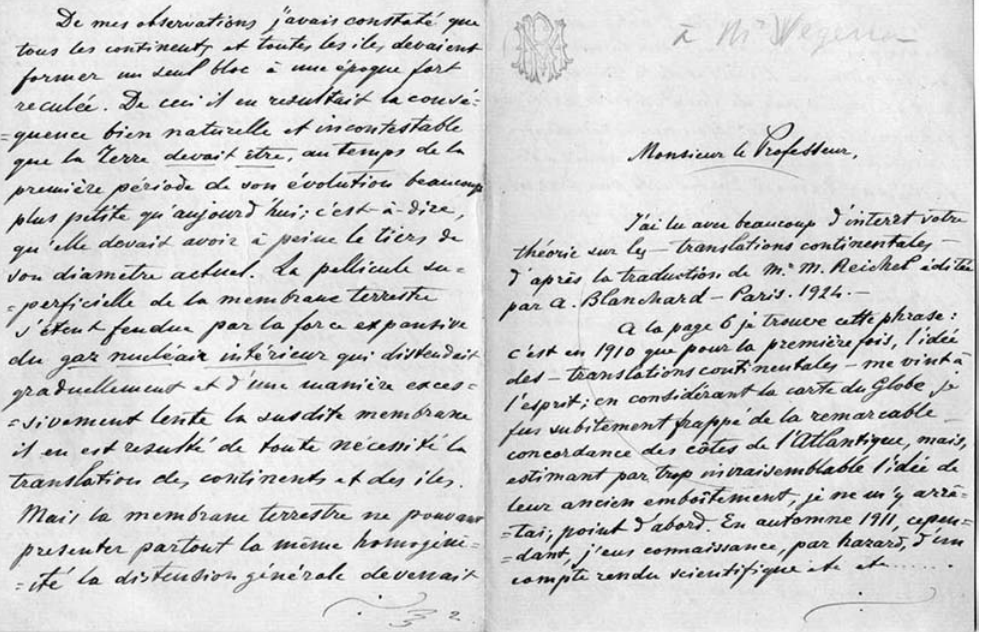
Fig. 2a-c. a) Rough copy of the letter of Mantovani to Wegener (property of Yvane Mantovani Poirier) with the aim to made clear to the German scientist that the priority of the idea of the continental dis- placements is antecedent to Wegener and Mantovani itself. See the translation in the text. b) The transla- tion in French of the answer of Wegener to Manto- vani (property of Yvane Mantovani Poirier), con- served by the Italian among the pages of the book of the German about the continental drift. See the trans- lation in the text. c) The answer of Mantovani to the scepticism of Wegener. The Italian wrote at page 209 (sheet 48) of his manuscript La dilatation planetaire: Such an objection is simply specious because it is completely impossible to assume that the outermost shell of the Earth has been able to contract so much as to cover a surface area less than a quarter of the to- tal surface of our planet. In addition, this is all the more true because the author of the objection admits that « the idea of an expansion of the Earth is certain- ly very convincing as far the huge fractures that oc- curred in the outer crust of the sphere » are con- cerned